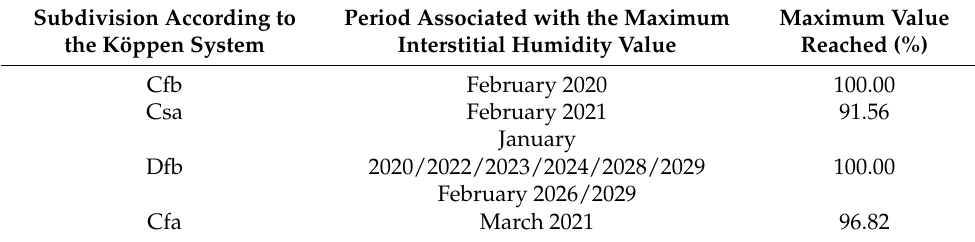
Figure 3. ( a ) Results of IRH values (%), maxima and averages, by subdivision according to the Köppen system. ( b ) Results of WCI values (kg/m 2 ), maxima and averages, by subdivision according to the Köppen system. Table 4. MIRH percentages recorded in the different climatic classifications of Köppen, associated with the period of formation of the maximum crevice humidity.